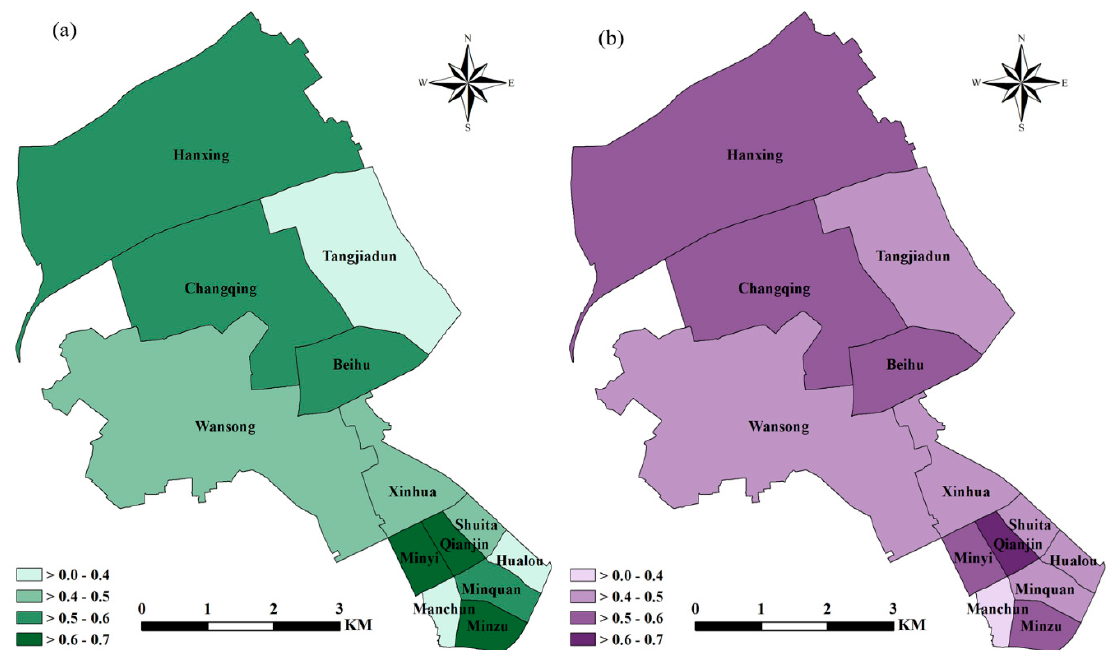
Figure 5. Posterior probabilities of ( a ) unstructured contextual effects and ( b ) spatially structured contextual effects having positive impacts on neighborhood burglary risks.